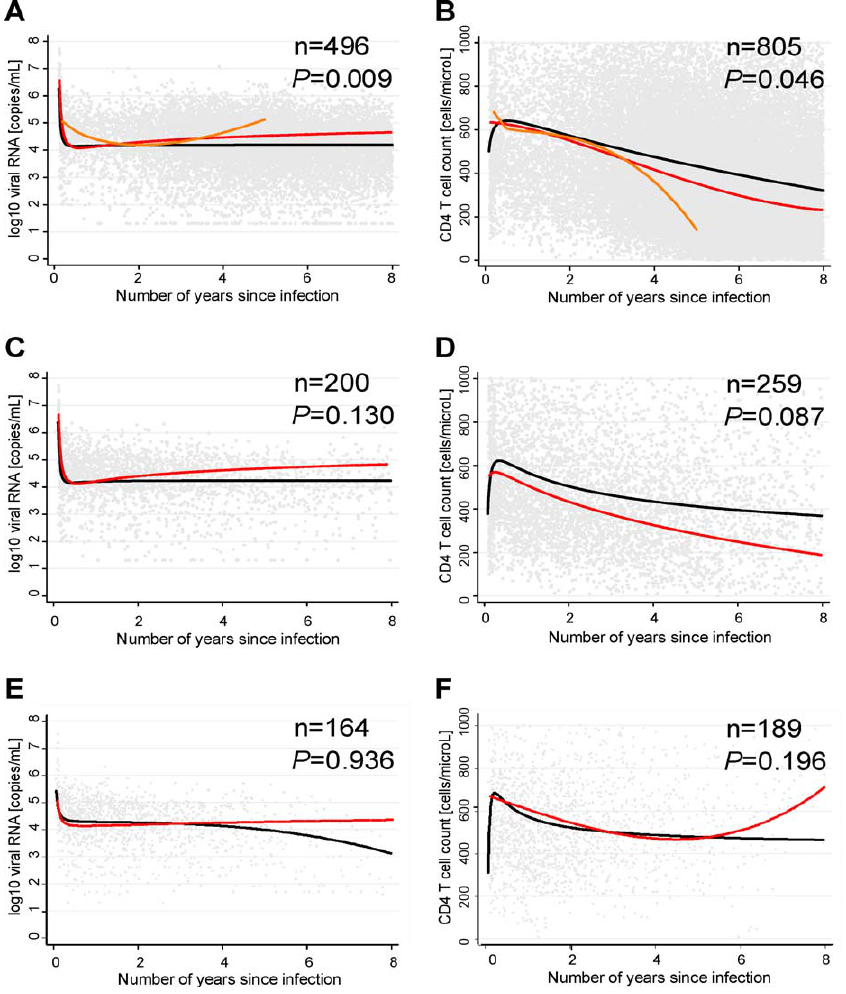
Figure 3. Assessment of rs2572886A in an HIV-1–Infected Human Cohort in the Absence of Therapy (A) Pattern of viral load in the full study population; each gray point represents a single viral load determination; the red (rs2572886A heterozygous), black line (individuals with the common allele), and orange lines (minor allele variant homozygous) represent the trend trajectories. (B) Pattern of CD4 þ T cell depletion in the full study population; each gray point represents a single CD4 þ T cell determination. (C) Pattern of viral load in infected individuals with known date of infection (incident sub-cohort). (D) Pattern of CD4 þ T cell depletion in the incident sub-cohort. (E) Pattern of viral load in the validation incident cohort. (F) Pattern of CD4 þ T cell depletion in the validation incident cohort.